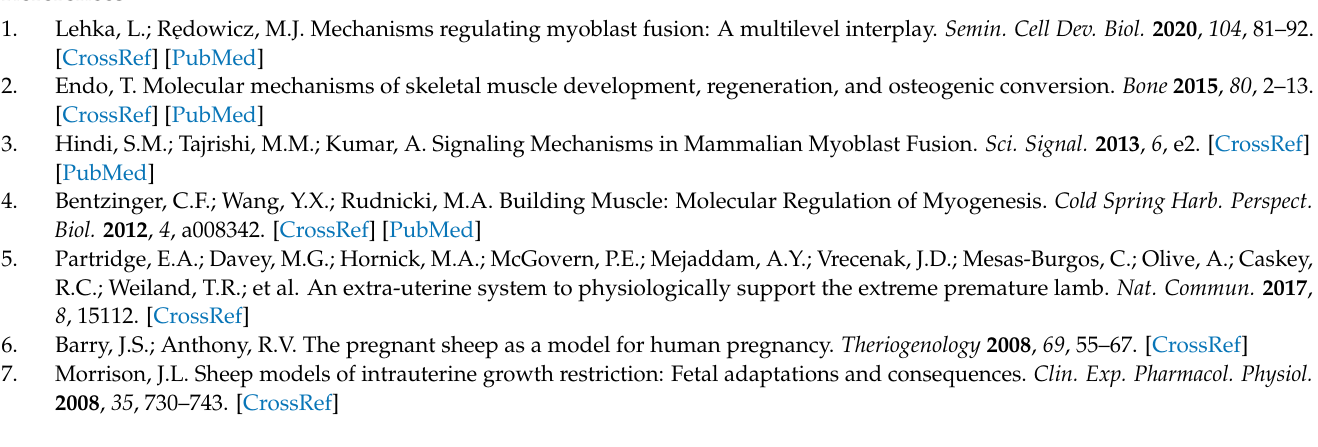
miRNAs, red triangles represent upregulated miRNAs, red circles represent upregulated differentially expressed genes, and purple circles represent downregulated differentially expressed genes. The nodes with a larger scale represent a higher degree; Figure S3. Bioprocess enrichment analysis of miRNA–TG: (A) GO analysis results for BINGO. Each circle represents an enriched category compared with the whole genome after false discovery rate correction. The size of each circle is proportional to the number of genes annotated to each node. The color of each circle indicates a p -value from 6 × 10 − 1 to 5 × 10 − 5 . (B) GO analysis results for ClueGo and CluePedia. The nodes represent DEGs. Circles, which are proportional to the number of genes annotated to the node, represent different enriched bioprocesses; Figure S4. The miRNA–target gene–pathway network. Table S1. Primers; Table S2. Sequence of TEAD1 siRNAs; Table S3. The miRNA expression profile; Table S4. The differential expression miRNA profile; Table S5. Network construction miRNAs; Table S6. Biological process of differential gene enrichment using